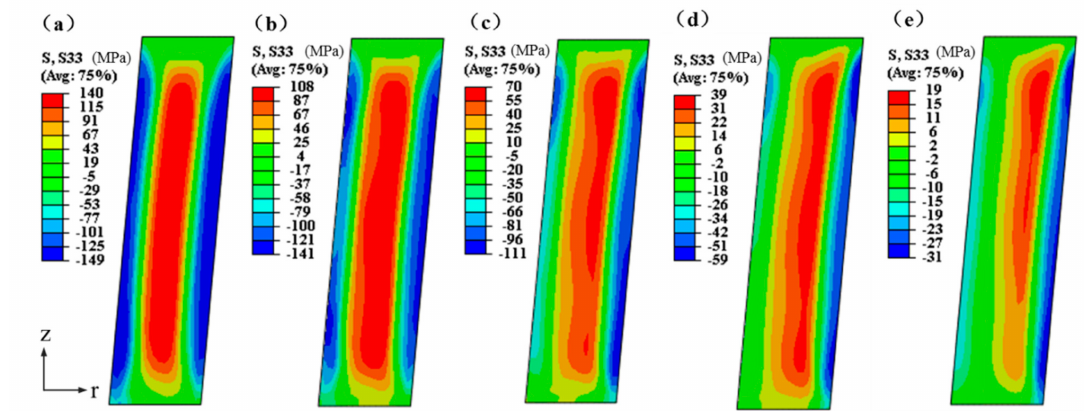
Figure 9. Residual stresses nephogram of the 2A14 tapered cylinder forging in the z-direction under different cold bulging ratio conditions: ( a ) 0%; ( b ) 1.0%; ( c ) 2.0%; ( d ) 3.0%; and ( e )